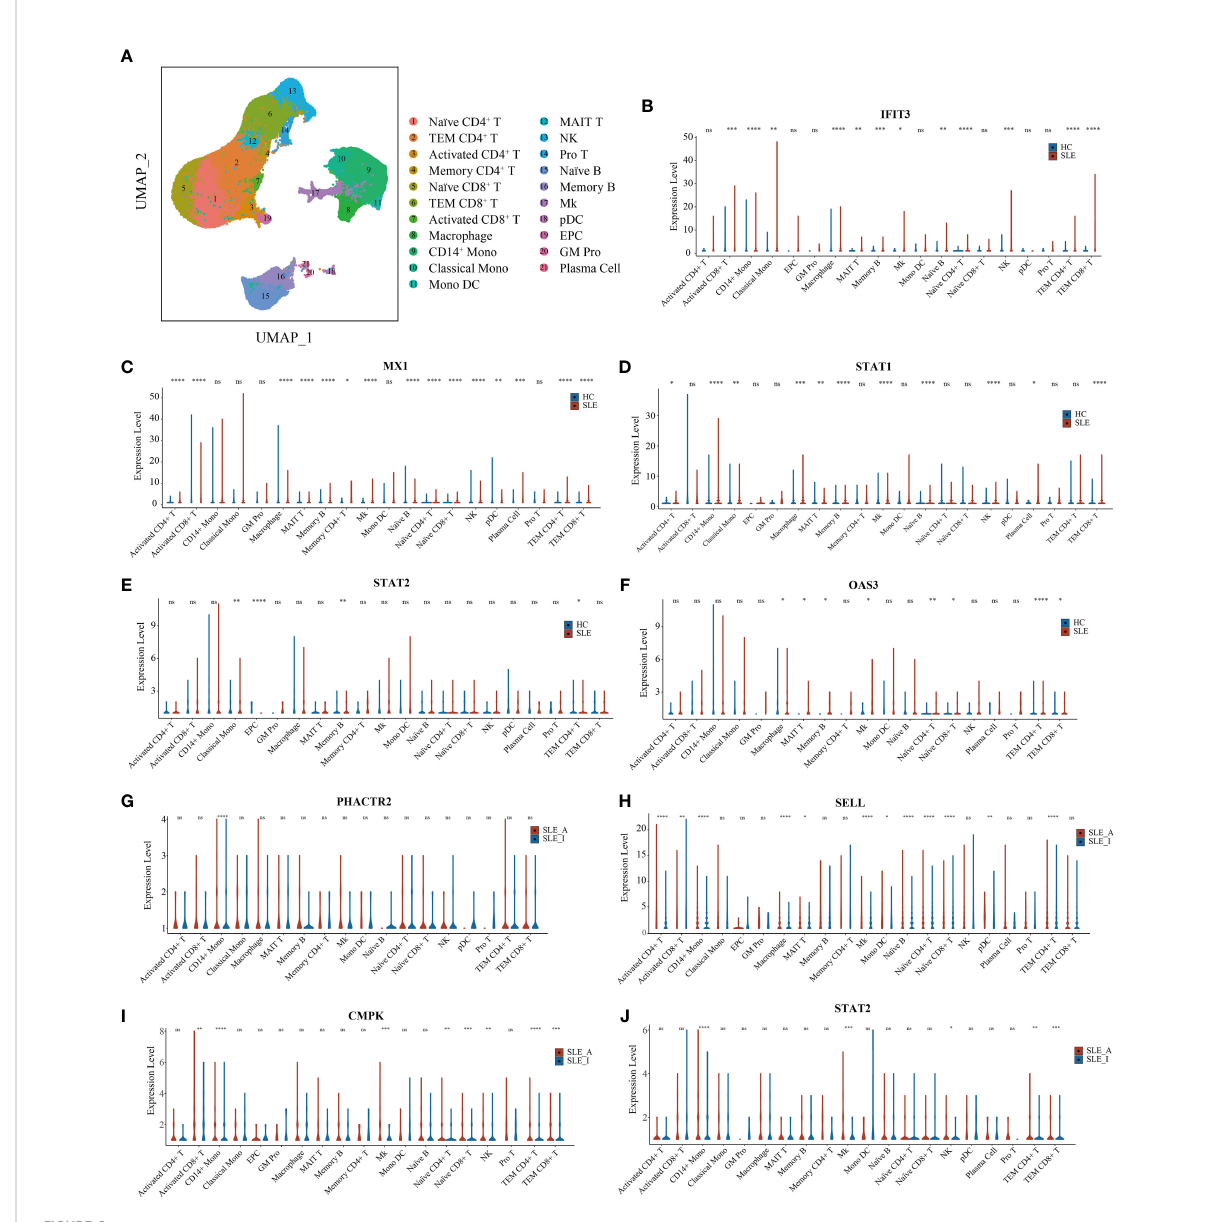
FIGURE 6 UMAP visualization for PBMC scRNAseq and Violin plots of scRNAseq data for SLE vs . HC and active SLE vs . inactive SLE. (A) Two-dimensional integrated UMAP visualization of PBMC cells combined from 46 SLE patient and 21 HC donors. PBMC were divided into clusters based on the expression of canonical genes. (B-F) Violin plots showing the differented expression pro fi le of fi ve SLE disease diagnosis related genes identi fi ed between SLE and HC; (G – J) Violin plots showing the differented expression pro fi le of four assessing disease exacerbation related genes identi fi ed between active SLE and inactive SLE (Wilcoxon rank sum test, P < 0.05). Red dot presents for HC or inactive SLE, and green dot presents for SLE or active SLE. * P < 0.05, ** P < 0.01, *** P < 0.001, **** P < 0.0001, ns, not signi fi